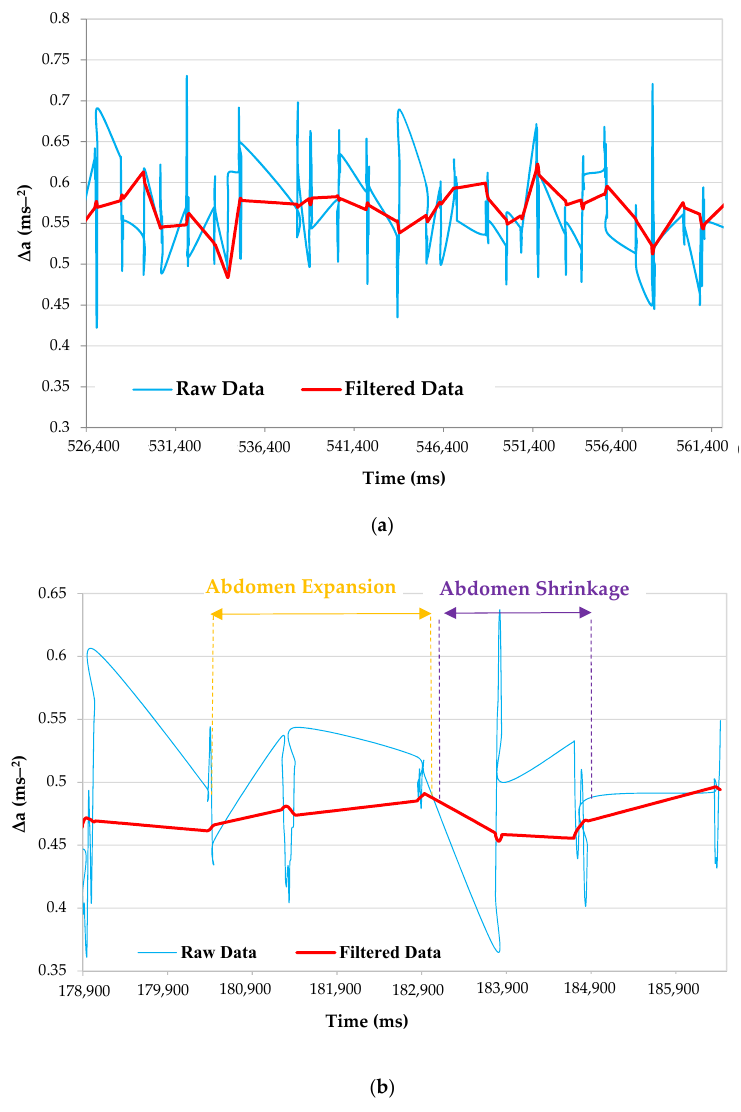
Figure 7. Plots showing the raw data (blue trace) and filtered data (red trace): wide ( a ) and detailed ( b ) views, with the inspiration and expiration phases highlighted. The front inertial sensor experienced a positive acceleration along the z -axis as the abdomen expanded due to breath inspiration, increasing the acceleration modulus dif- ference signal. In contrast, as the abdomen contracted during expiration, the front IMU experienced a negative acceleration along the z -axis, because it tended to return to its in- itial position, thus, reducing the resulting differential signal (Figure 7a). Figure 7b pro- vides a more in-depth view of the collected waveforms.